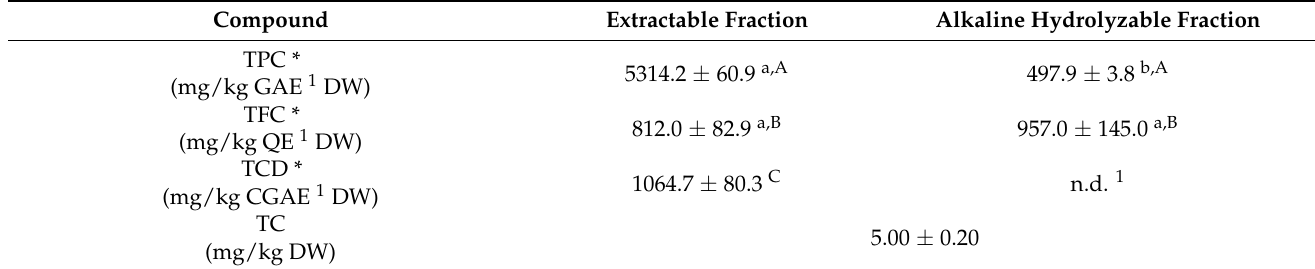
Table 1. Phytochemical composition (mg/kg dry weight) in bee-collected artichoke